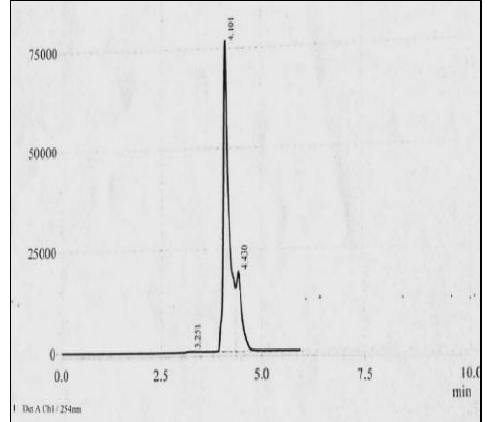
Figure 10 . HPLC chromatogram of isolated alkaloid .